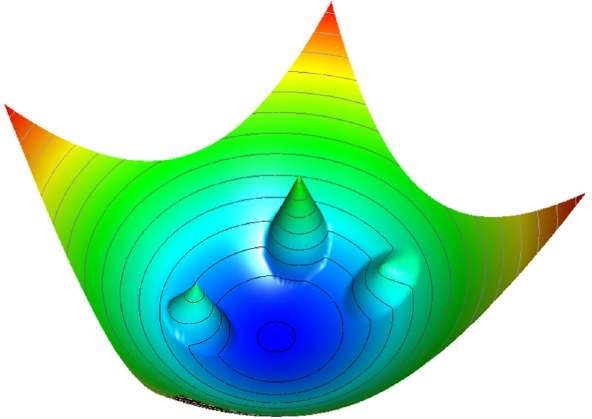
Fig. 1 Illustration of the effective potential that is affecting a vertex belonging to the condensation point of the object in the centre, in the presence of three other condensation points around